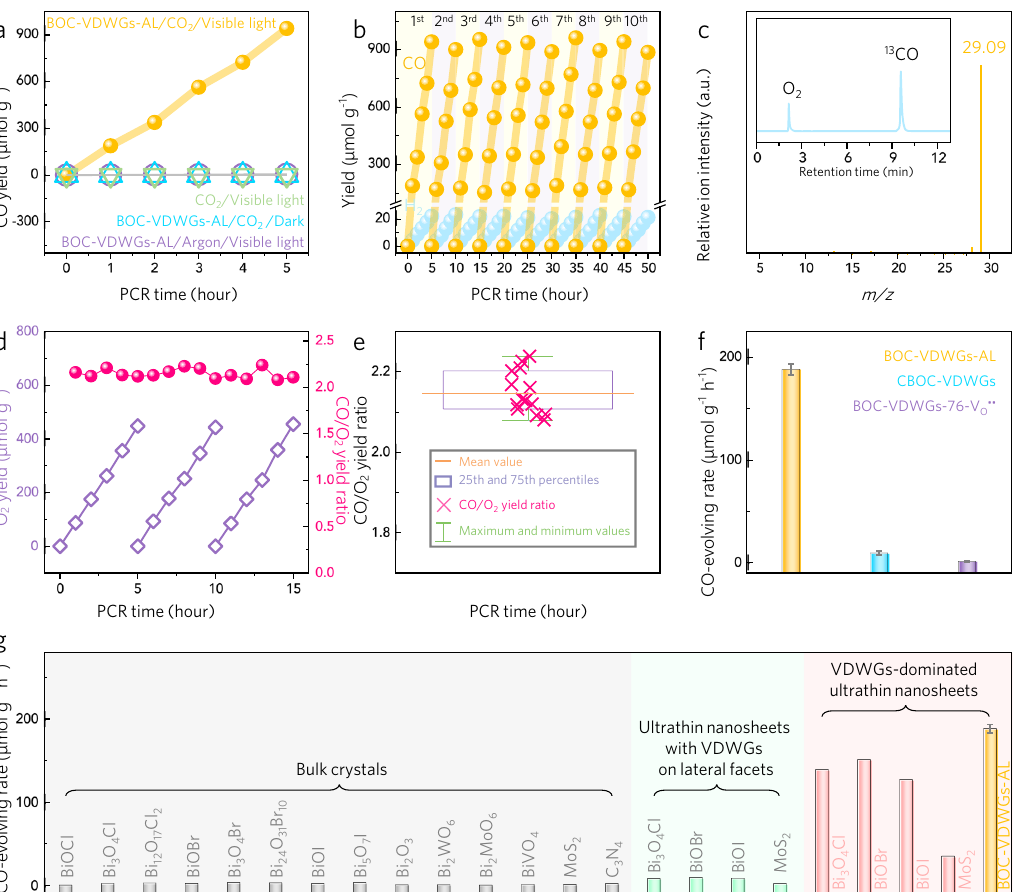
Fig. 2 Pure-water PCR performances of VDWGs-rich BiOCl atomic layers. a CO yields of four parallel experiments of pure-water PCRs. The fi rst used BOC-VDWGs-AL under visible light in the presence of CO 2 , the second did not involve BOC-VDWGs-AL but still using visible light and CO 2 , the third involved BOC-VDWGs-AL and CO 2 but under dark, and the fourth employed BOC-VDWGs-AL and visible light but fed with argon. b Cycling tests of pure- water PCR performances over BOC-VDWGs-AL for 50 hours. c Mass spectra of the product generated from pure-water PCR over visible-light-irradiated BOC-VDWGs-AL fed with 13 CO 2 . The inset in panel c shows the corresponding GC pattern. d Yield of O 2 detected during pure-water PCR photocatalyzed by BOC-VDWGs-AL, as well as the calculated yield ratio of CO to O 2 . This set of data were obtained from an online PCR system. e Statistical result for the CO/O 2 yield ratio. f Comparison of CO-evolving rate of BOC-VDWGs-AL, CBOC-VDWGs, and BOC-VDWGs-76, all under visible light in the presence of pure-water and CO 2 . g Comparison of pure-water, CO-evolving rate of BOC-VDWGs-AL and some representative layered photocatalysts. The nanosheet photocatalysts with VDWGs on lateral facets were obtained by conventional exfoliation method, while VDWGs-dominated nanosheets were synthesized by our developed exfoliation strategy. The error bars derived from triplicate